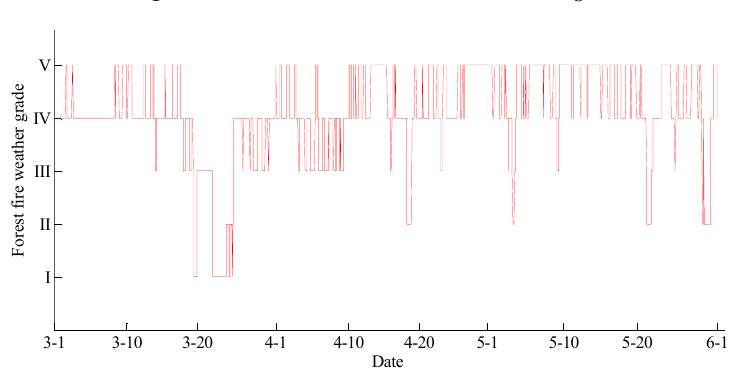
Figure 14. The curve of the forest fire weather grade in Yan’er Ridge.